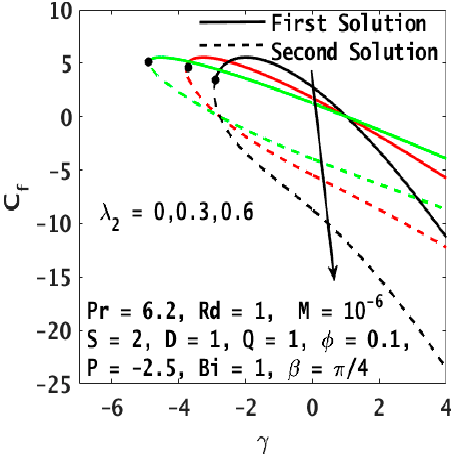
Figure 3. Variation of C f with λ 2 . Crystals 2021 , 11 , x FOR PEER REVIEW